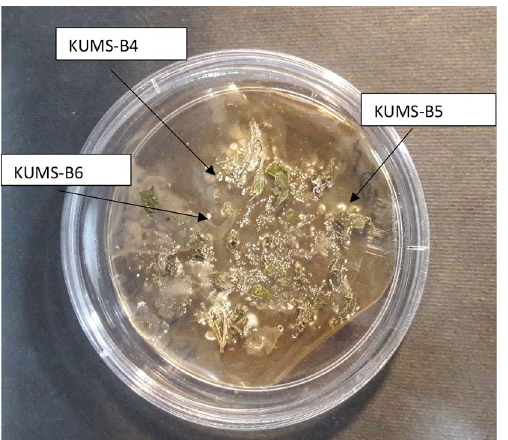
Figure 1. The emerging of actinobacteria from surface sterilized leaves following 6–8 weeks incubation on YECD medium. The arrows show colonies emerging from the surface-sterilized leaf tissue for KUMS-B4, KUMS-B5 and KUMS-B6